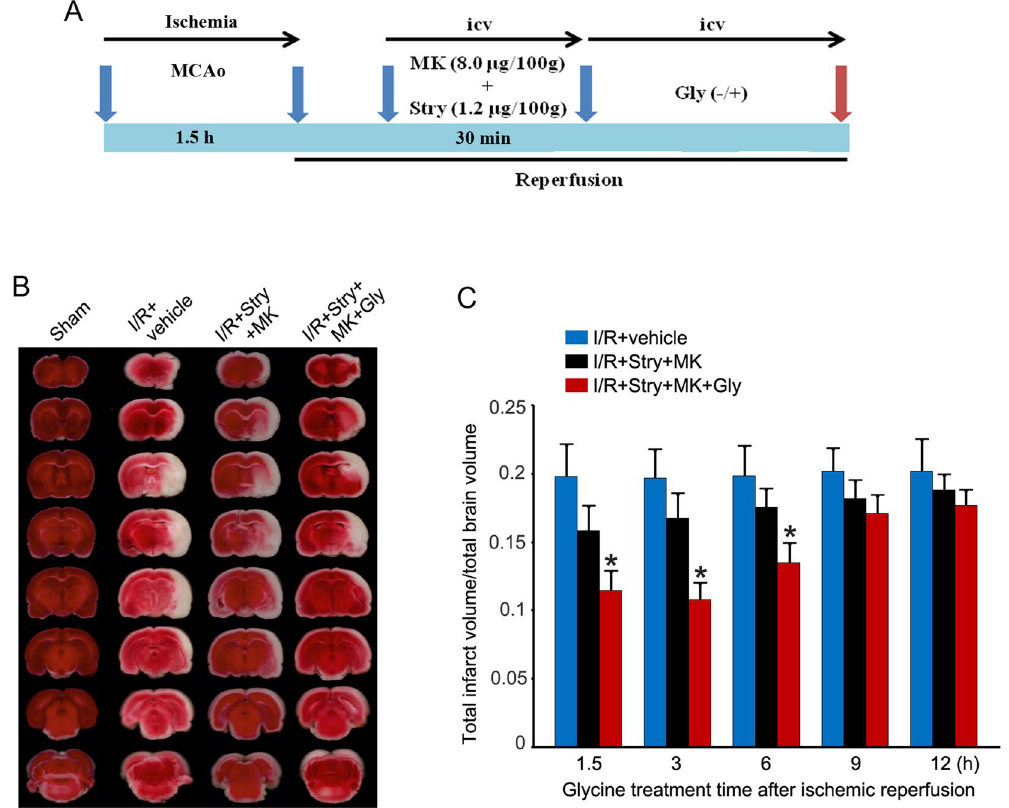
Figure 1. Glycine treatment reduces the infarct volume of ischemic brain independent of glycine receptor activation and the channel activity of NMDARs. ( A ) A schematic diagram showing rat cerebral ischemia- reperfusion injury and glycine treatment procedure. ( B ) Sample images of TTC strained-brain sections collected at 24 h after ischemia onset. Glycine (100 µ g/100 g, icv) was administered at 3 h following ischemia- reperfusion (I/R). At 30 min prior to glycine injection, MK-801 (8.0 µ g/100 g, icv) and strychnine (1.2 µ g/100 g, icv) were injected. ( C ) Summarized quantification data indicate that glycine treatment at 1.5, 3, or 6 h following I/R reduces infarct volume after glycine receptors and NMDARs are inhibited (n = 10 for each group; ANOVA test, * P < 0.05 vs. I/R + Stry + MK). Stry: Strychnine; Gly: glycine; MK: